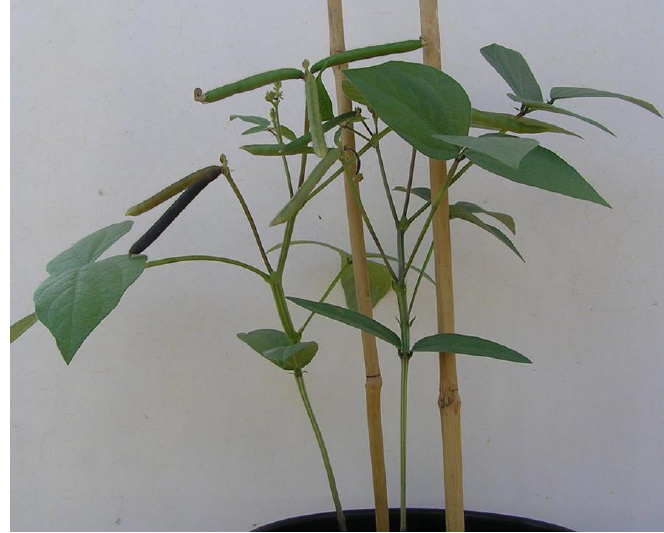
Figure 4. Mungbean plants grown in pots showing trifoliate leaves and determinate morphology.